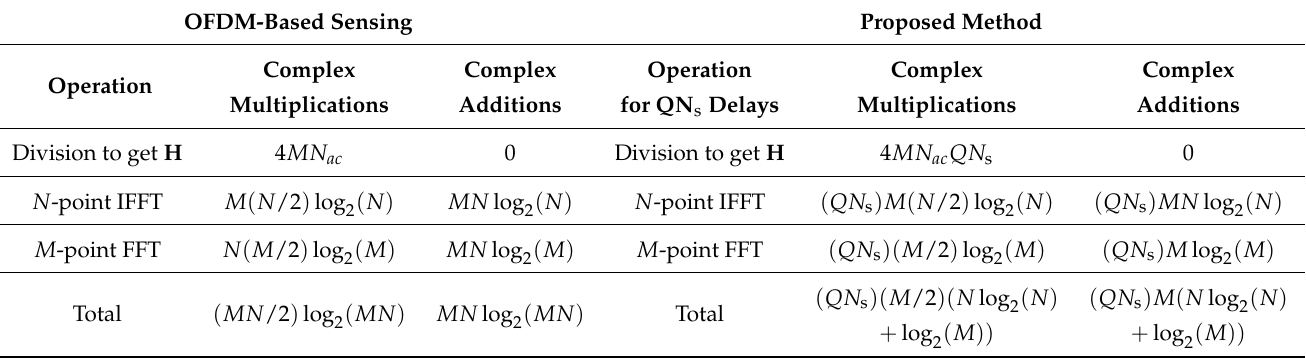
Table 1. Computational complexity of the proposed method.